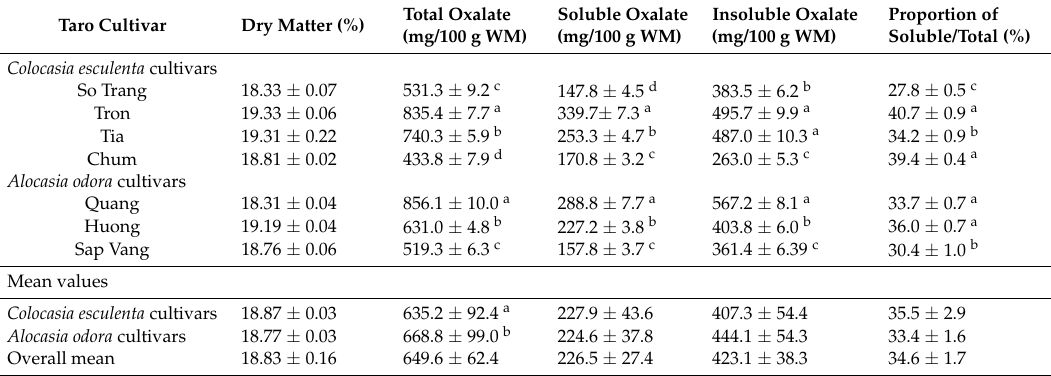
Table 2. Total, soluble and insoluble oxalate content (mg/100 g WM) in the leaves of seven different taro cultivars grown in central Vietnam (mean values ±